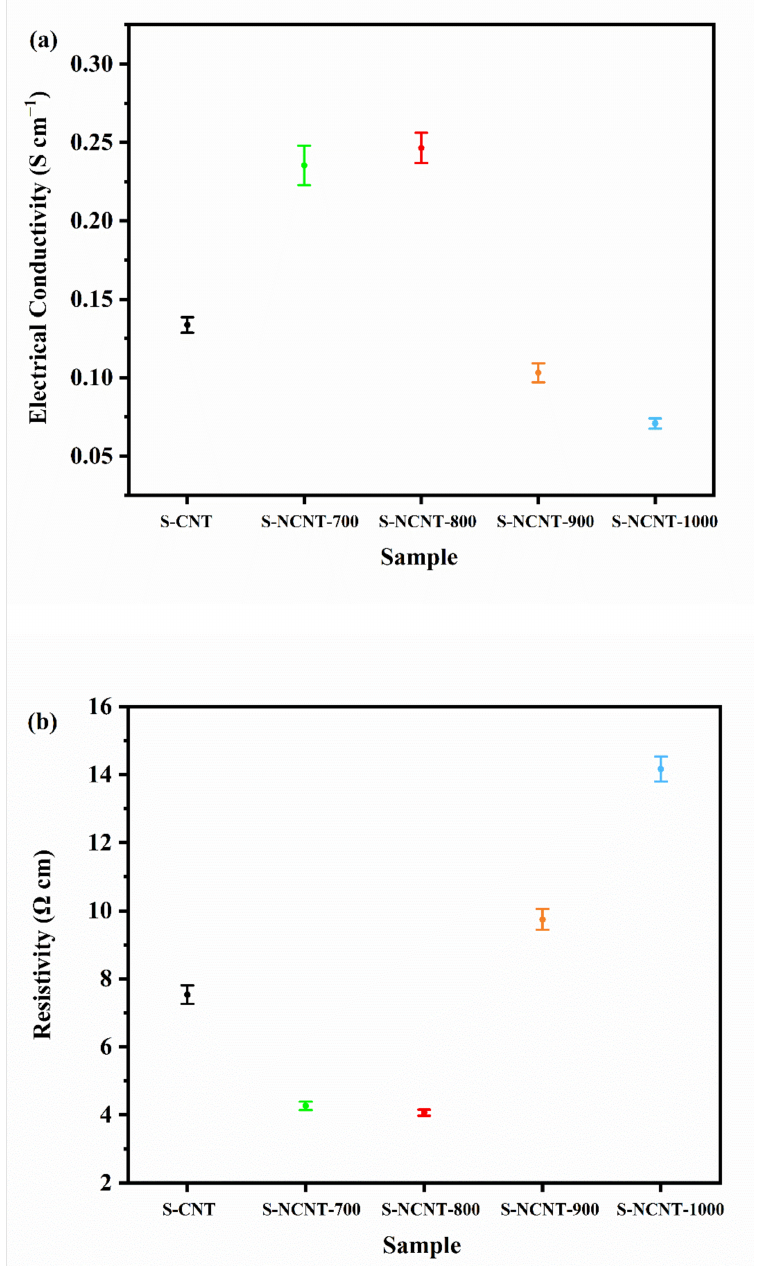
Figure 6. ( a ) Electrical conductivity and ( b ) resistivity of cathodes coated on insulating